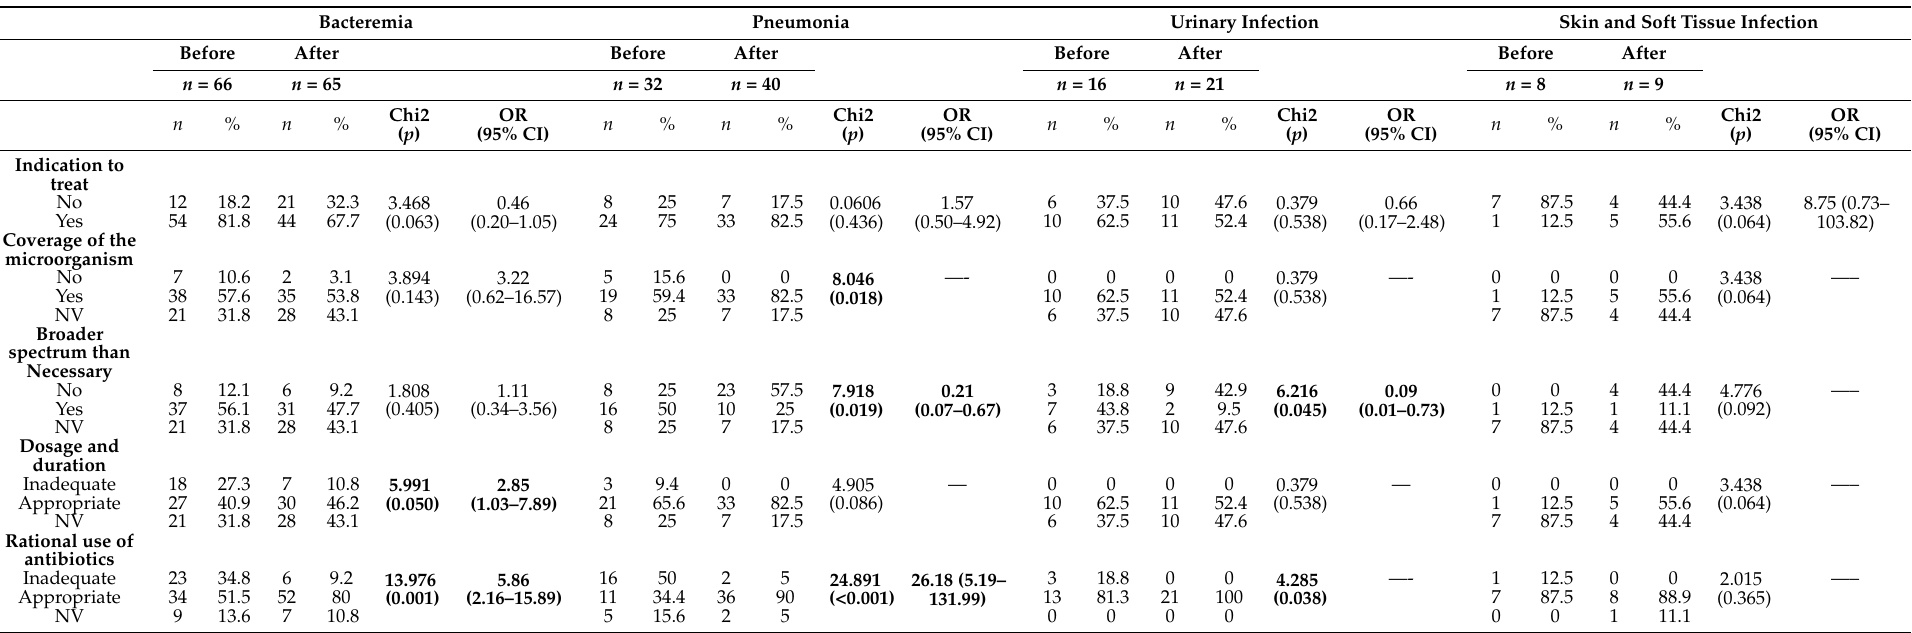
Table 3. Comparison of the observed practice of prescription in targeted treatments in 122 patients before and 135 patients after the training. Bacteremia